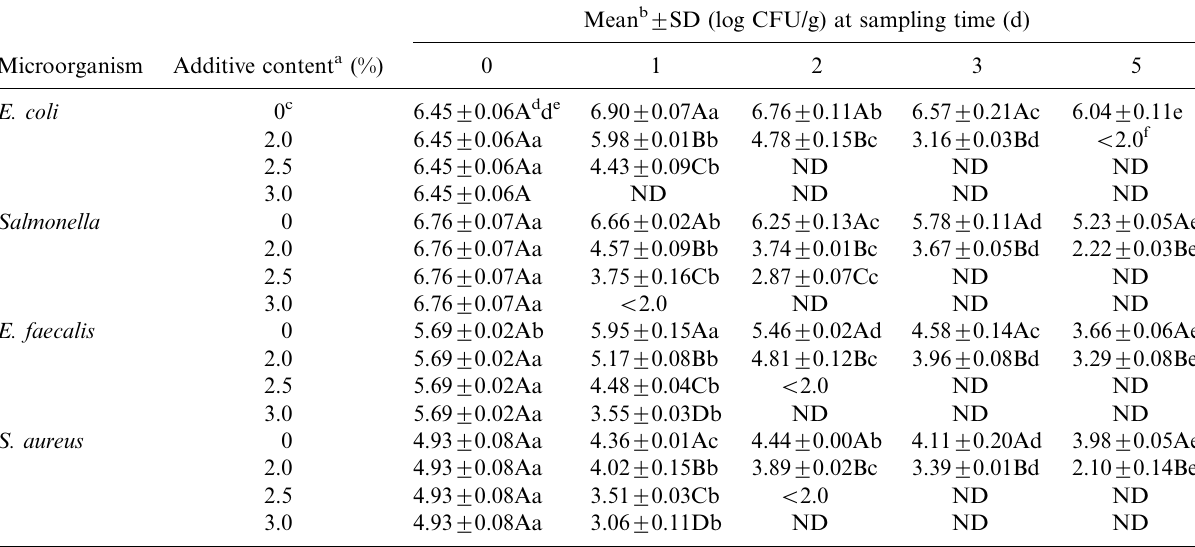
Table 3. The survival and persistence of E. coli , Salmonella , E. faecalis and S. aureus during cattle manure composting with addition of different contents of CaCN 2 at 30 8 C